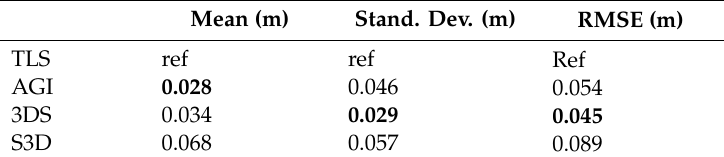
Table 7. Boulder No. 1: point distances